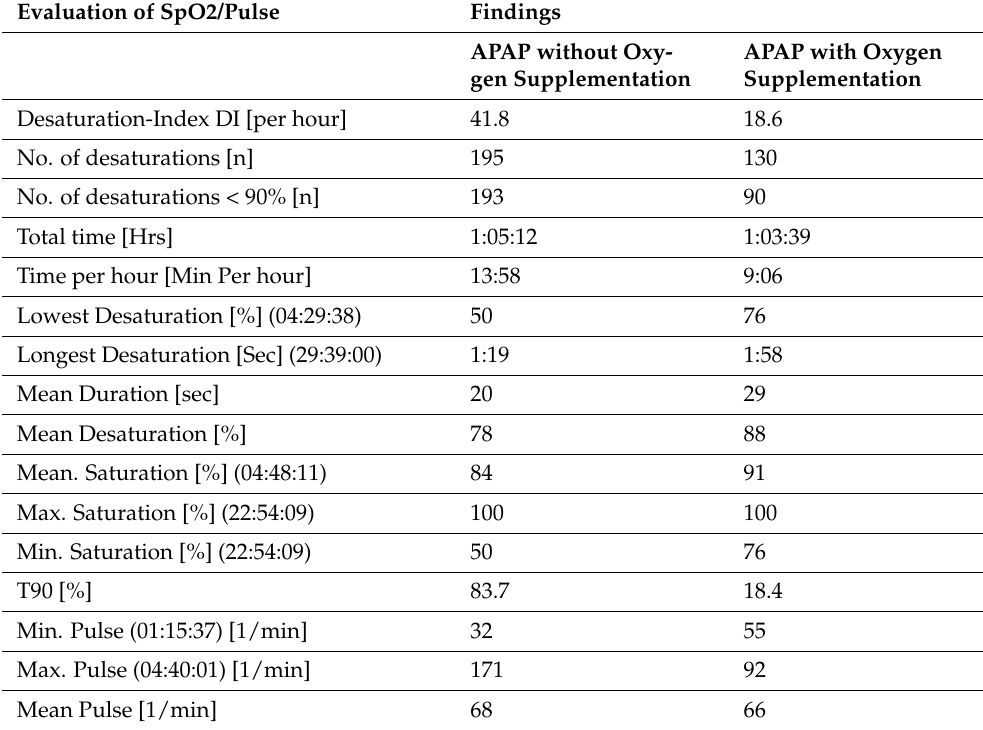
Table 3. Polysomnographic SpO2 and pulse parameters after surgery and PAP implementation. Evaluation of SpO2/Pulse